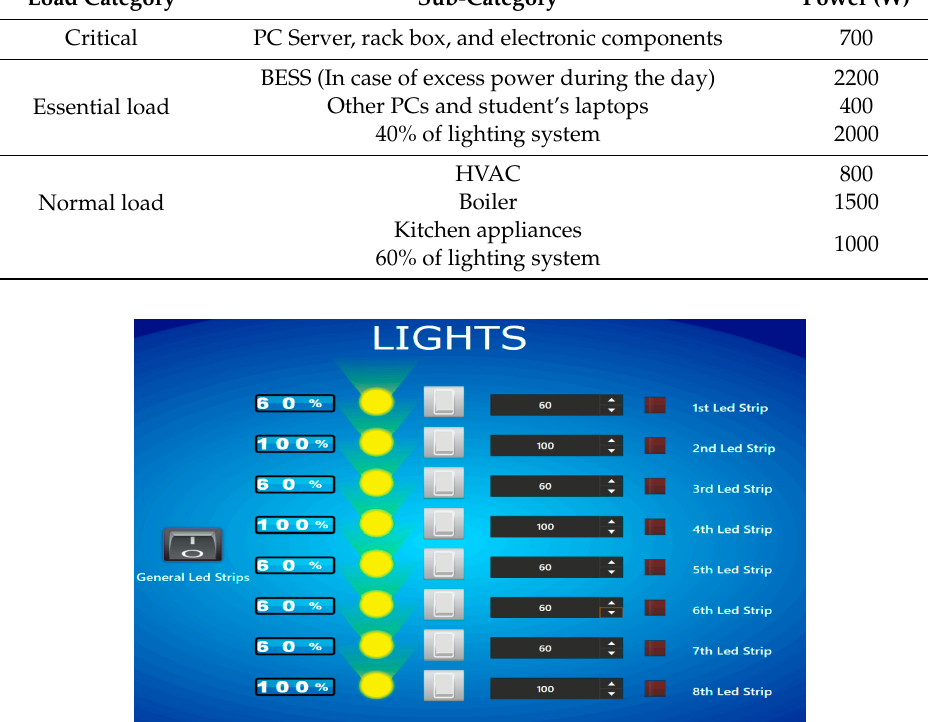
Figure 5. Lighting zone classification in LAMBDA lab.